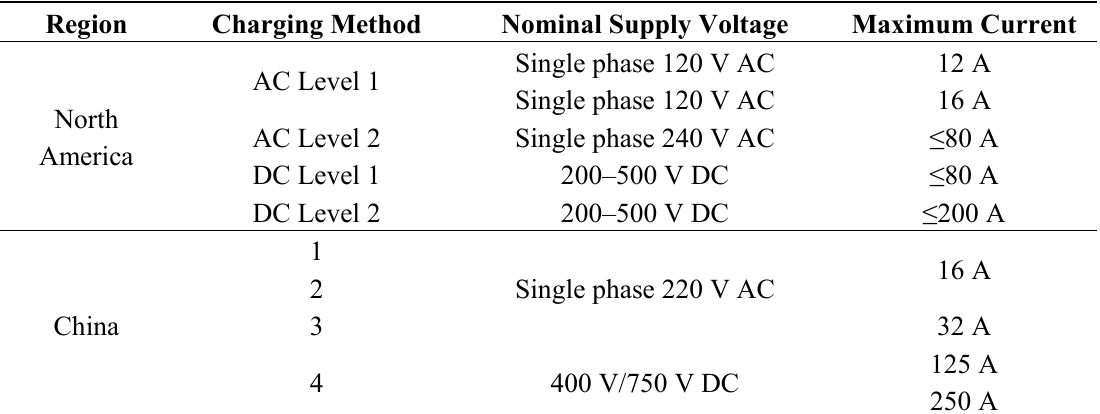
Table 1. North America and China charging levels for electric